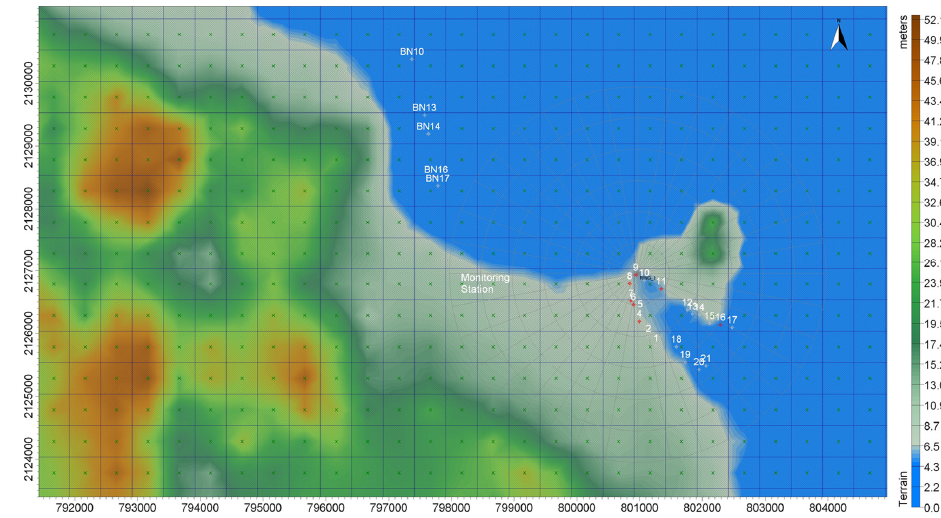
Figure 4. Air quality modeling area from the WebGIS CALPUFF model.